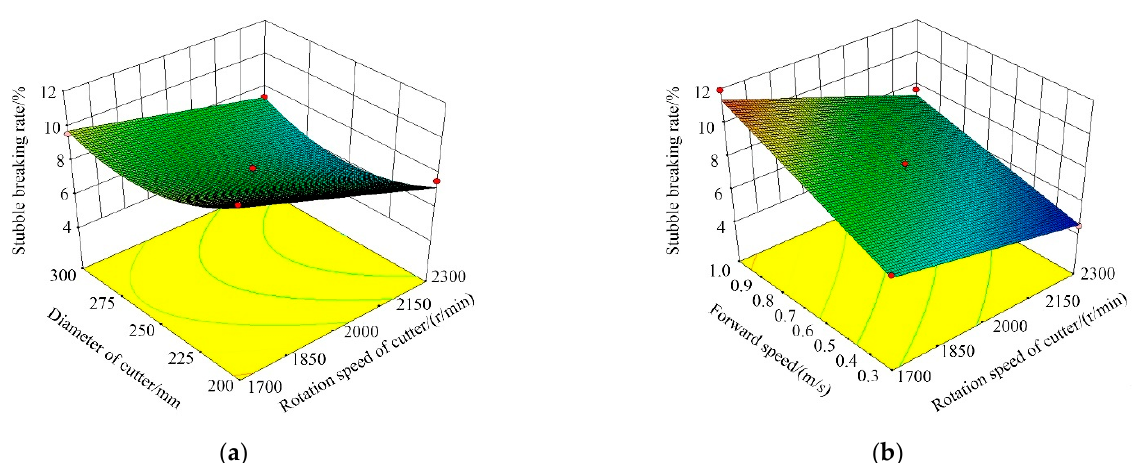
Figure 14. Response surface diagrams of influence of significant interaction factors on stubble breakage rate. ( a ) X 3 = 0.65 m/s; ( b ) X 2 = 250 mm.